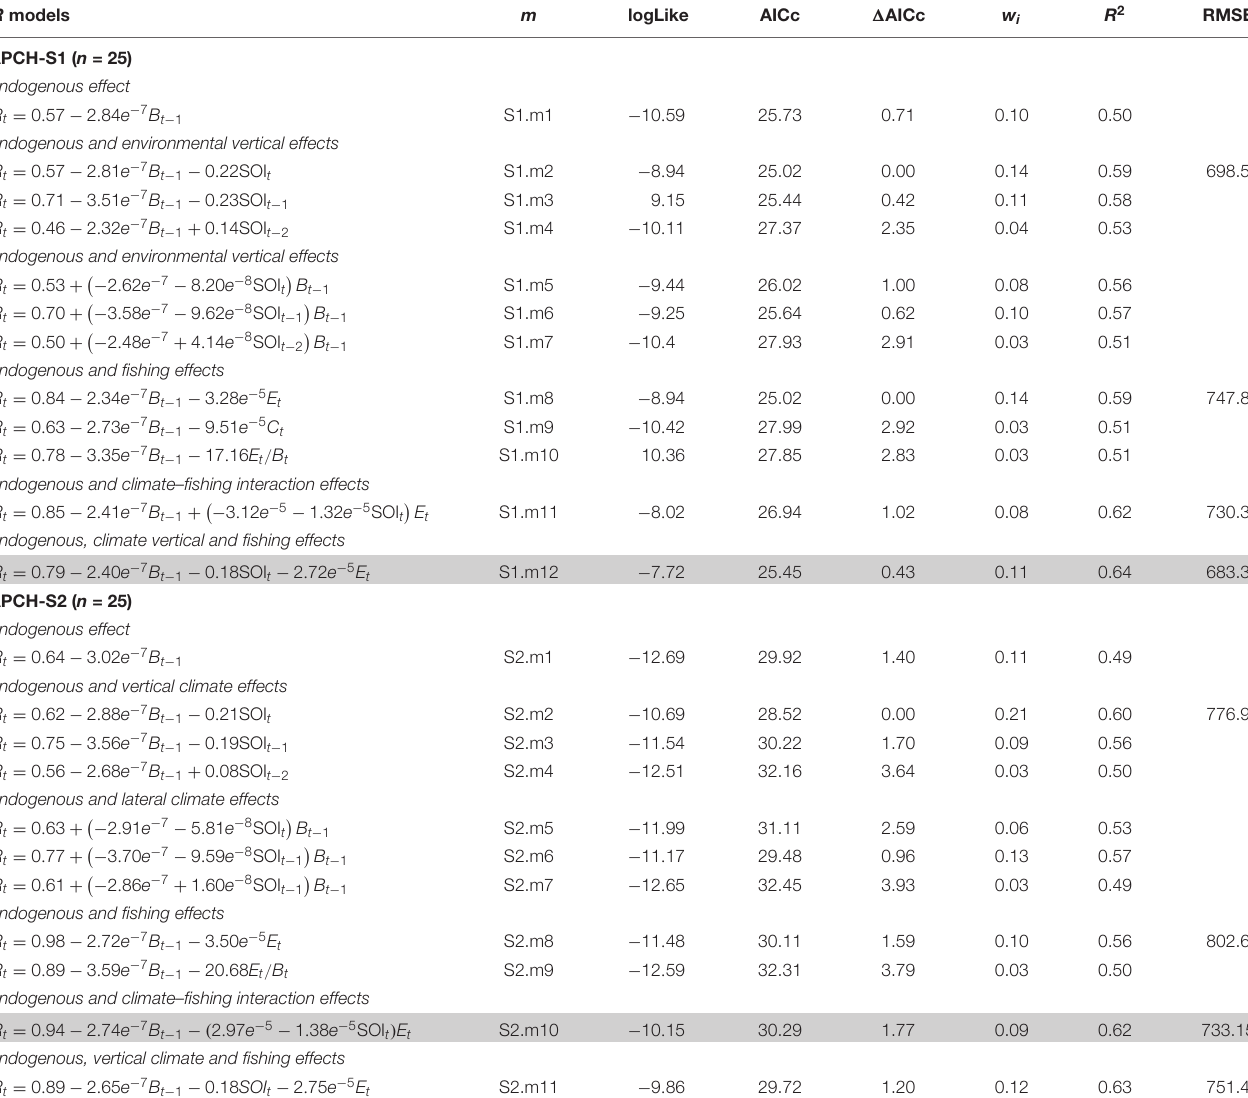
TABLE 1 | Population models for the Chilean anchovy stocks ( Engraulis ringens ). R models m logLike AICc (cid:49) AICc w i R 2 RMSE